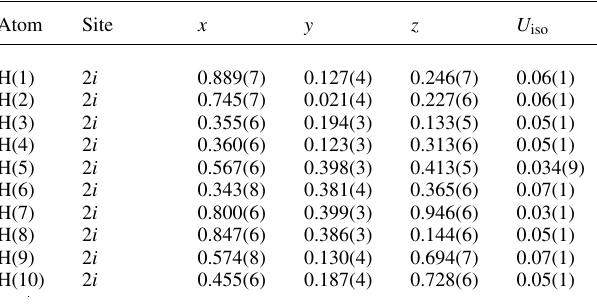
Table 2. Atomic coordinates and displacement parameters (in Å 2 )